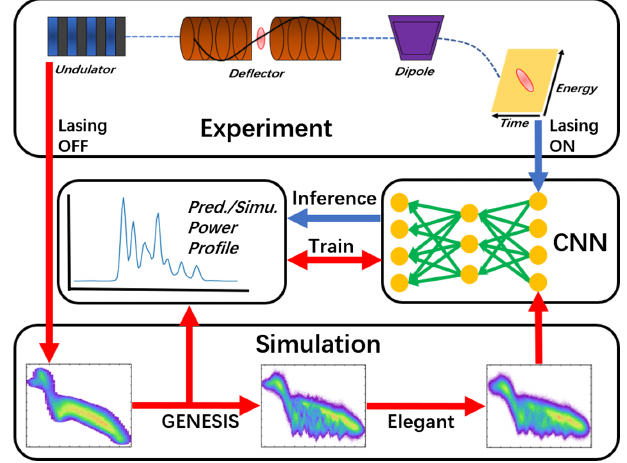
FIG. 1. The power reconstruction problem in the machine learning paradigm. The red flow represents simulation-driven neural network training. The XTCAV measures the lasing-off electron beam, approximating the longitudinal phase-space at the entrance to the undulator. These lasing-off images serve as input to the GENESIS/elegant simulation pipeline, which outputs both the final longitudinal electron beam phase-space and the corre- sponding x-ray power profile. The simulated electron beam and x-ray power profile pairs then train a convolutional neural network. The blue flow indicates the inference step on new experimental data. We collect the lasing-on phase-space from the XTCAV camera and directly input the plot to the CNN to predict the power profile.